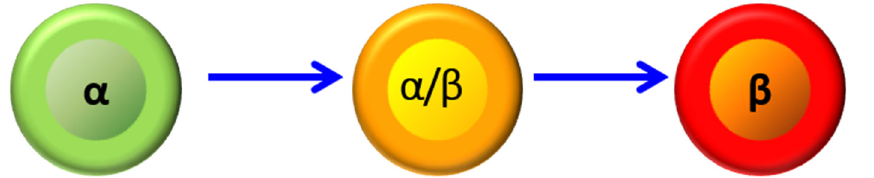
Figure 1. α - to β -cell transdifferentiation. A-cells expressing glucagon (green) transdifferentiate to b-cells expressing insulin (red) through an intermediate co-expressing glucagon and insulin (yellow). Scale bar 10 μ m.